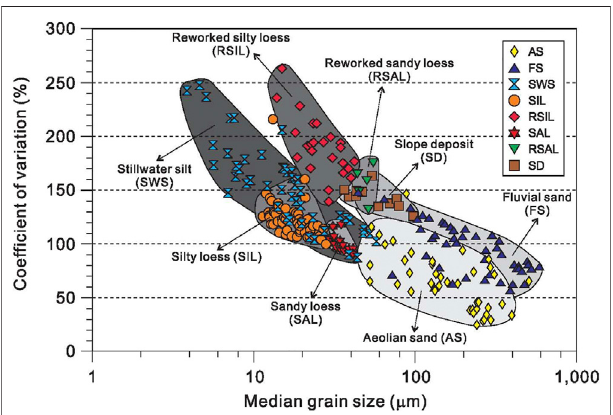
FIGURE 4 | The coef fi cient of variation (CV) plotted against the median grain size of classi fi ed surface sediment types in the Hexi Corridor (modi fi ed after Nottebaum et al., 2014). The coef fi cient ofvariation (CV) isan indicator of thedegreeofsortingprocessre fl ectedbythestandarddeviation(StD),a discrimination parameter of GSD of sediment types. AS, aeolian sand; FS, fl uvial sand; SWS, stillwater silt; SIL, silty loess; RSIL, reworked silty loess; SAL, sandy loess; RSAL, reworked sandy loess; SD, slope deposit.